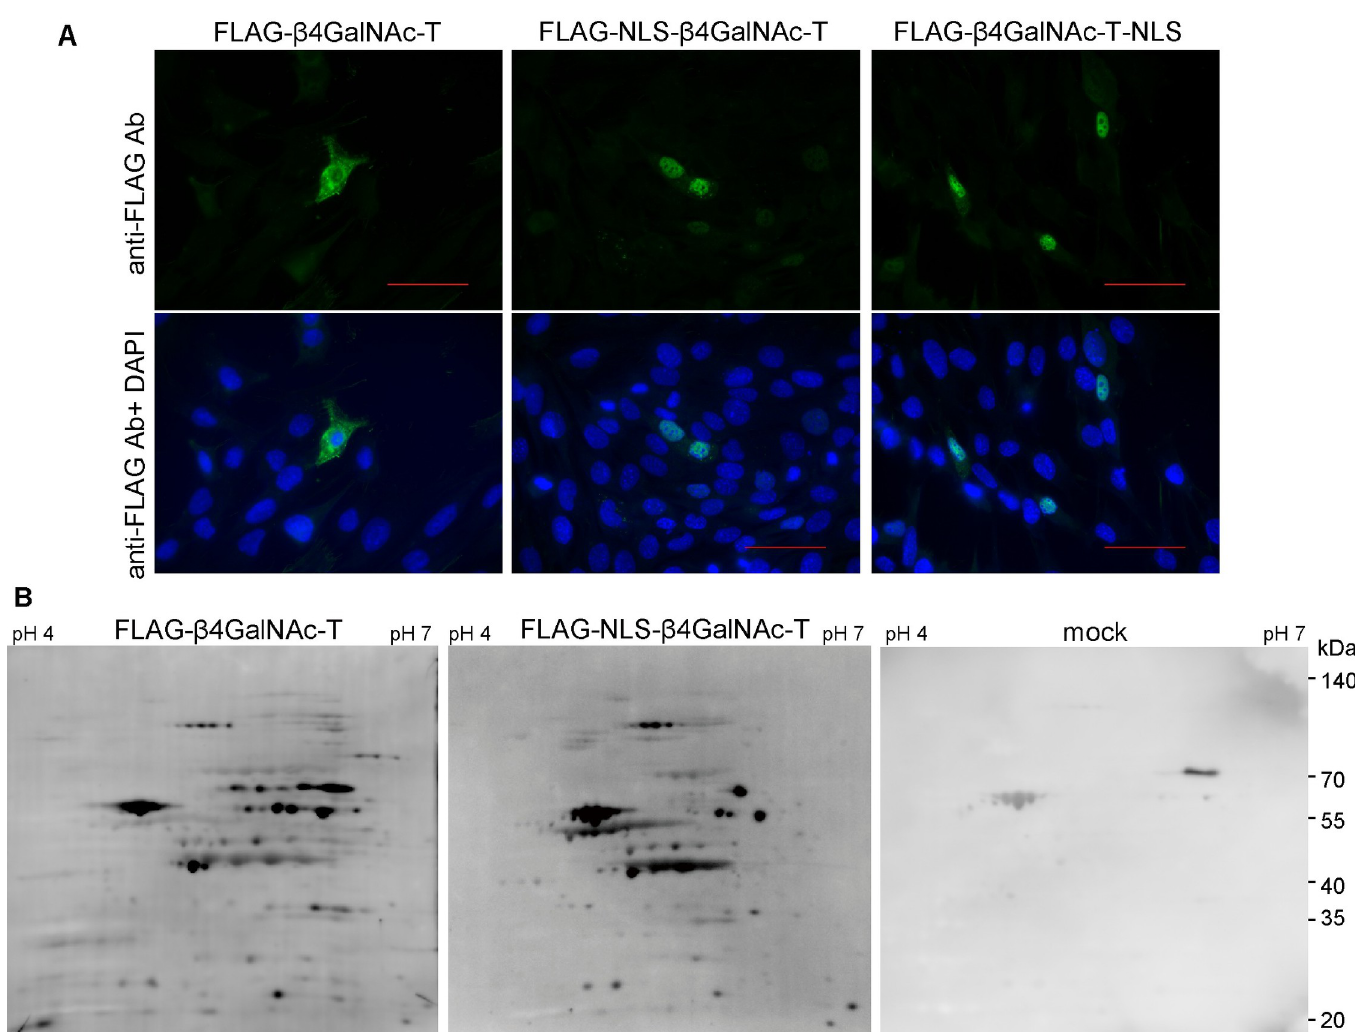
Fig 3. A modified disaccharide-tag method using a β 4GalNAc transferase with a nuclear localization signal. (A) Expression of FLAG-tagged soluble β 4GalNAc transferase with or without nuclear localization signal (NLS). HEK293 cells expressing FLAG-tagged soluble β GalNAc (FLAG- β GalNAcT), FLAG-tagged soluble β GalNAc with NLS at N-terminus (FLAG-NLS- β GalNAcT), or FLAG-tagged soluble β GalNAc with NLS at C-terminus (FLAG-NLS- β GalNAcT) were stained with Alexa488-labeled anti-FLAG Ab and DAPI. White bar indicates 10 nm. (B) O-GlcNAcylated proteins in mouse pancreatic ductal adenocarcinoma cells (YamaPaca-6) transfected with pFLAG-CMV3-NLS- β 4GalNAc-TA, pFLAG-CMV3- β 4GalNAc-TA, or pFLAG-CMV3 (mock), respectively, were detected by disaccharide-tag method.